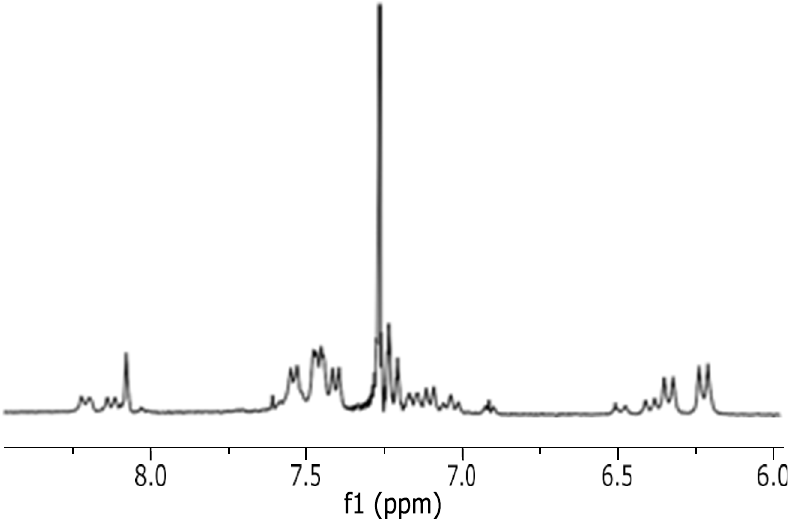
Figure 3. 1 H RMN Spectrum of 12 in CDCl 3 with the extended aromatic region in which the amide proton signals are present.